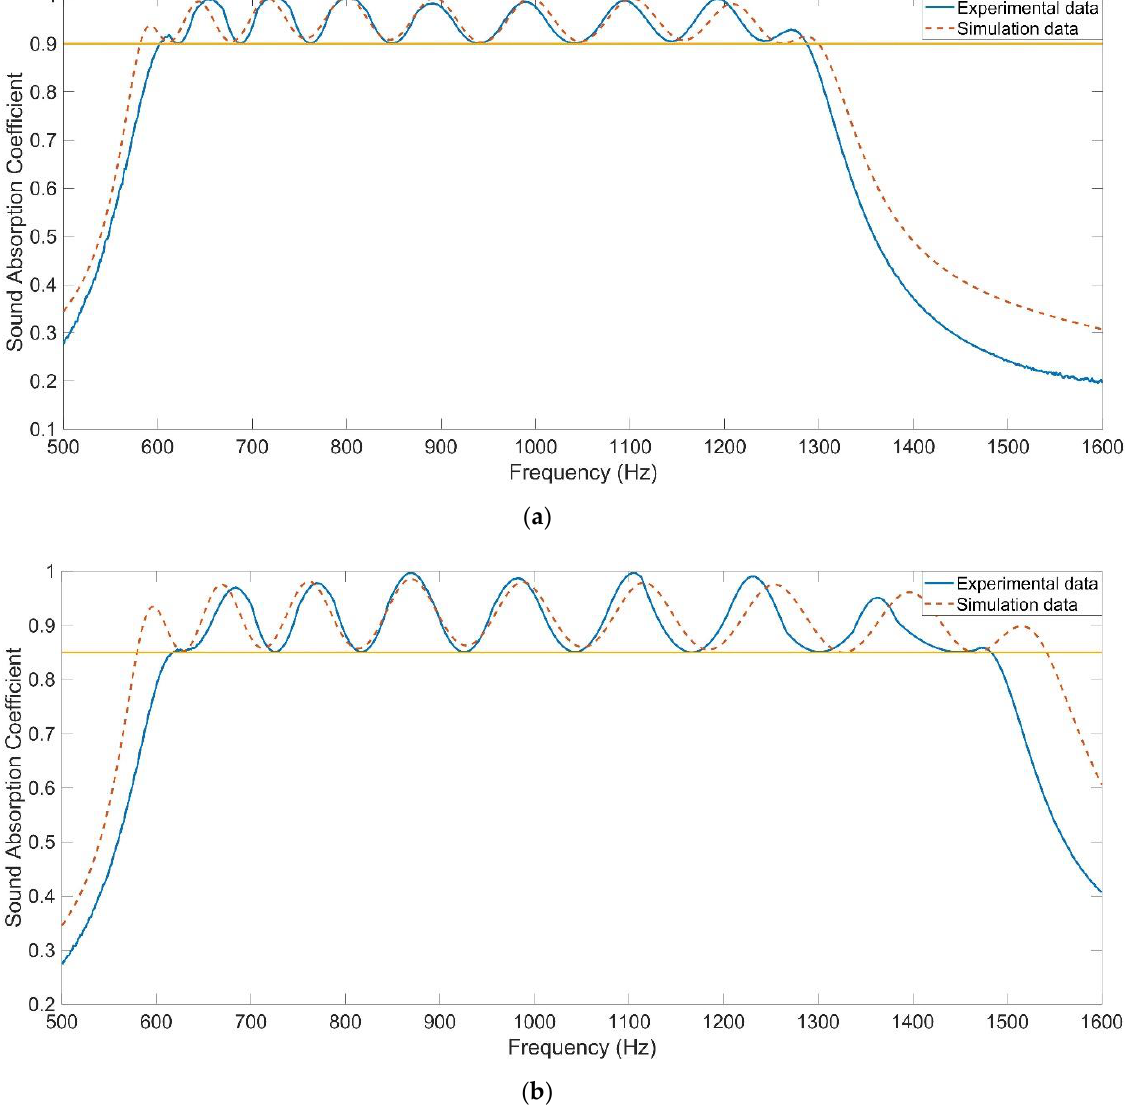
Figure 11. Distributions of sound absorption coefficients of the optimized APH-AM samples in actual and those obtained in finite element simulation. ( a ) For the target with all the sound absorption coefficients above 0.9; ( b ) For the target with all the sound absorption coefficients above 0.85. Table 6. The summary of the peak sound absorption coefficient α max and resonance frequency f 0 in actual and those in simulation for the optimized APH-AM samples.